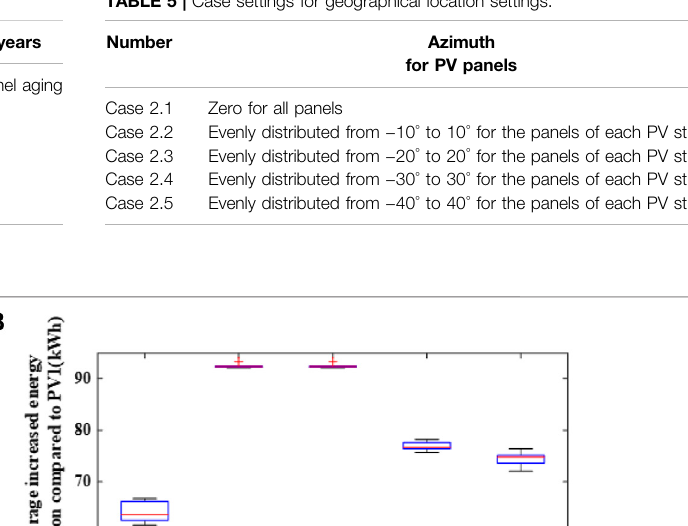
Figure 11 : (A) annual total energy production of LPPs and (B) the average increased energy production per hour (marked in the red lines) for PV2~PV6 compared to PV1 in case 2.5. Similar to